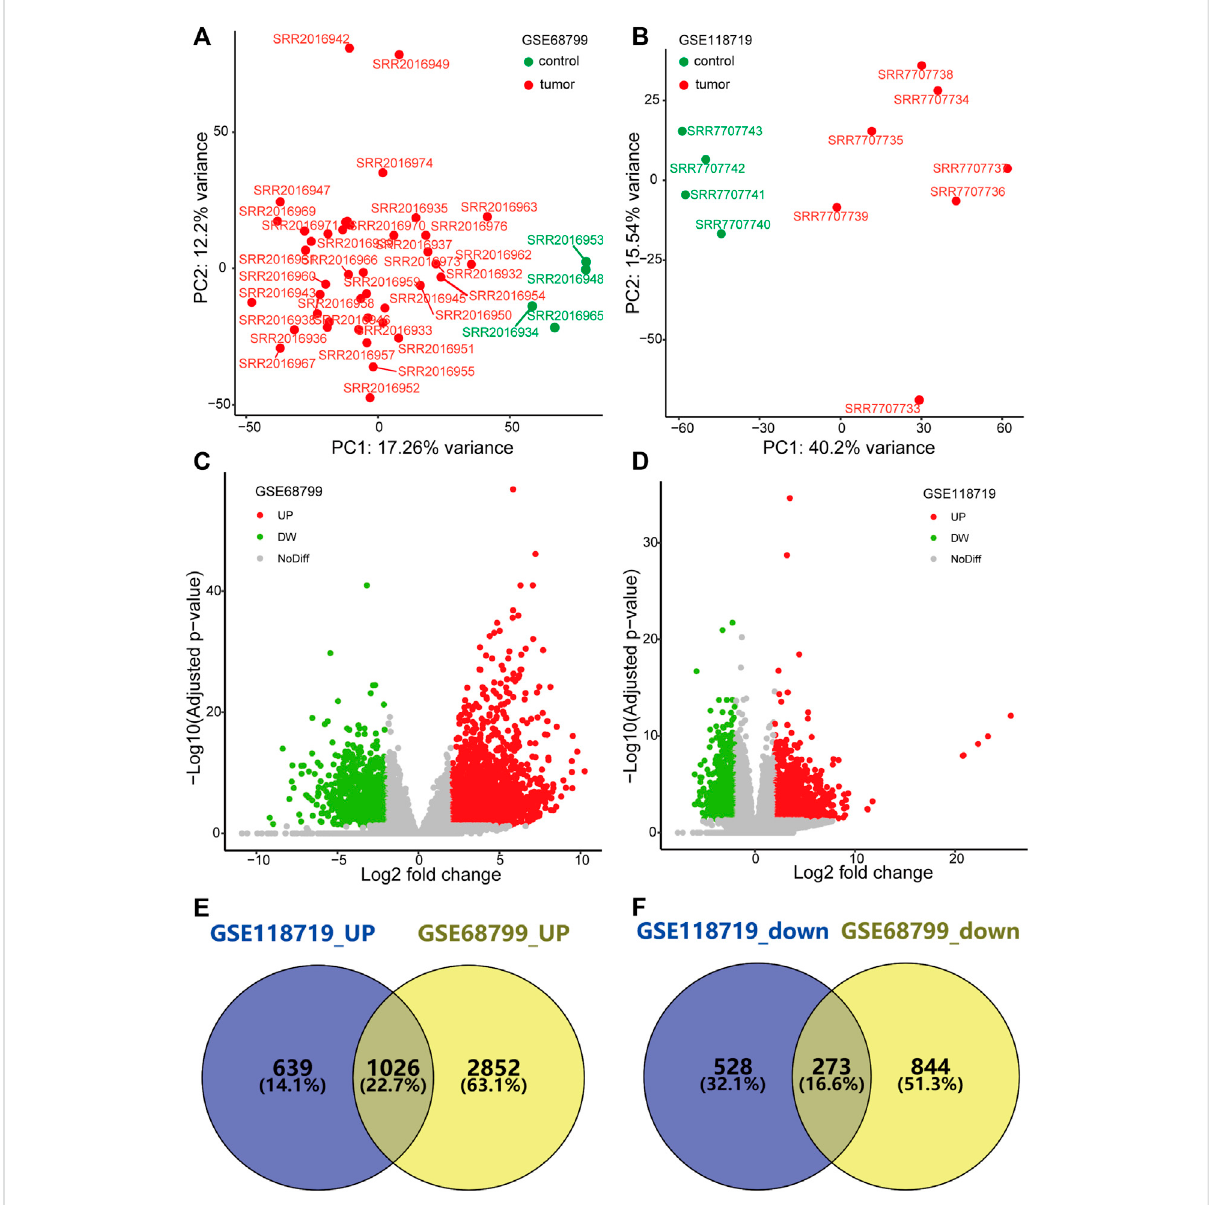
FIGURE 1 Identi fi cation of differentially expressed genes (DEGs). (A,B) PCA plots show that genes from GSE68799 and GSE118719 were mainly classi fi ed into the tumor cluster and the control cluster. (C,D) Volcano plots present the distribution of DEGs with thresholds of FDR < 0.05 and |log2 FC| > 2 in GEO datasets GSE68799 and GSE118719. (E,F) Venn diagrams show the common genes of upregulated and downregulated DEGs from the two